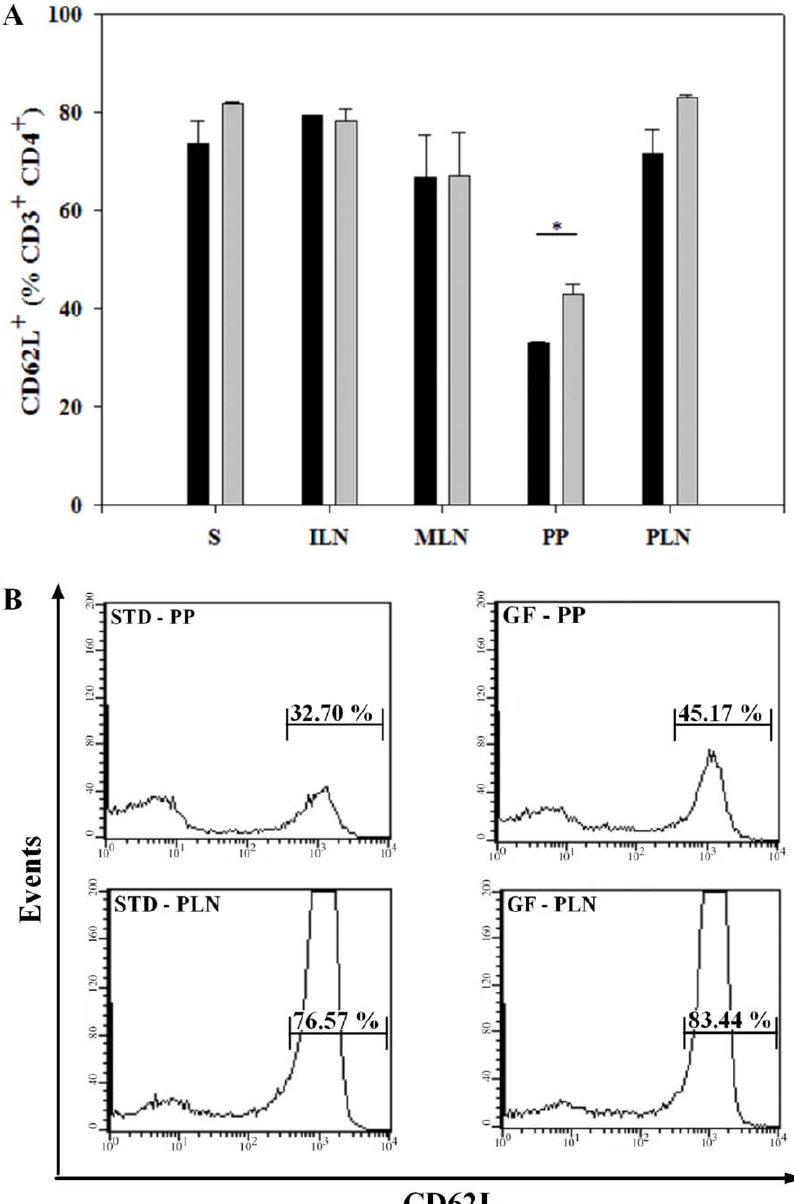
Figure 5. Fewer CD4 + T cells in PP expressed CD62L in mice receiving the STD diet. ( A ) Bars represent percentages of CD62L + cells gated on 100% CD3 + CD4 + cells. In BALB/C mice receiving the STD diet, compared to mice receiving the GF diet, there was a decreased proportion of CD4 + CD62L + T cells in PP. Data are presented as mean values 6 SEM of two independent experiments with 6 mice in each group. ( B ) Representative histograms from PP and PLN showing the differences in CD4 + CD62L + T cells. Spleen (S); inguinal lymph nodes (ILN); mesenteric lymph nodes (MLN); Peyer’s patches (PP) and pancreatic lymph nodes (PLN).Black bars: STD diet. Grey bars: GF diet. * P , 0.05.